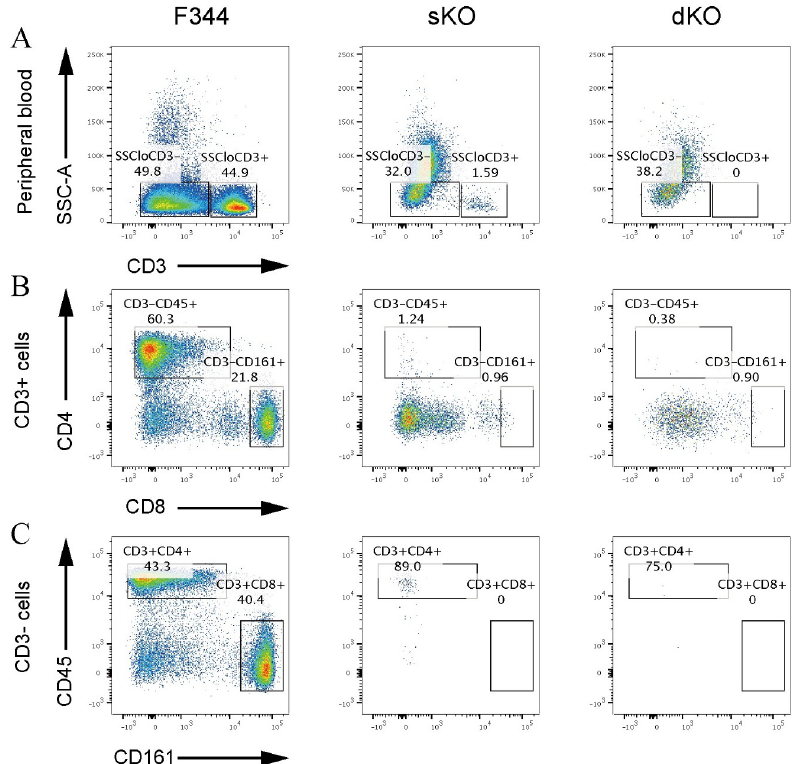
Fig 4. Flow cytometry analysis of cell populations in peripheral blood. (A) Analyses of SSC and CD3. Dot plots show the distributions of the cells after lymphoid gating. The SSC low/CD3 + T cell group is indicated in the box as SSCloCD3 + . (B) Analyses of CD4 and CD8. Dot plots show the distributions of CD3 + cells. (C) Analyses of CD45RA and CD161a. Cells from the SSCloCD3 − gate were divided into groups. CD3 − /CD45RA + B cells and CD3 − /CD161a + NK cells are shown in the